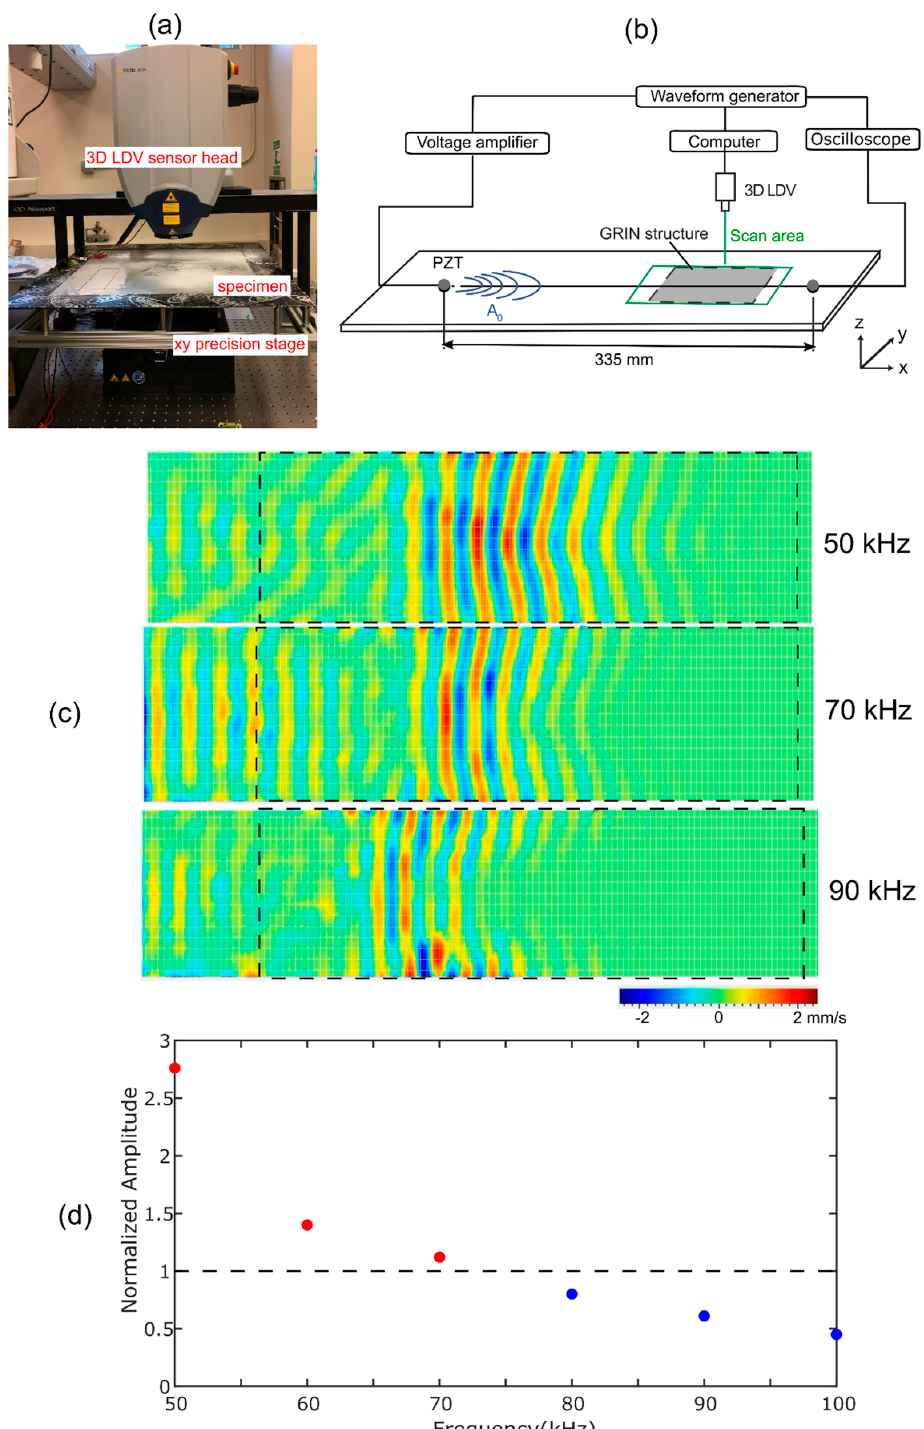
Figure 3. Measurement of the focus performance of the GRIN structure for A 0 mode: ( a ) photograph of the 3D LDV measurement system. ( b ) Schematic of experimental setup. ( c ) LDV measurements of z -directional surface velocity due to propagating A 0 Lamb waves. Wave propagation is from left to right. Dashed rectangle is the GRIN region. 50 kHz wave recorded at 275 µs; 70 kHz wave at 216 µs; 90 kHz wave at 183 µs. ( d ) Amplitudes of the output PZT response as a function of the input A 0 mode frequency, normalized to reference case without GRIN structure. Red data points have an amplitude above and blue data points below the reference value respectively.